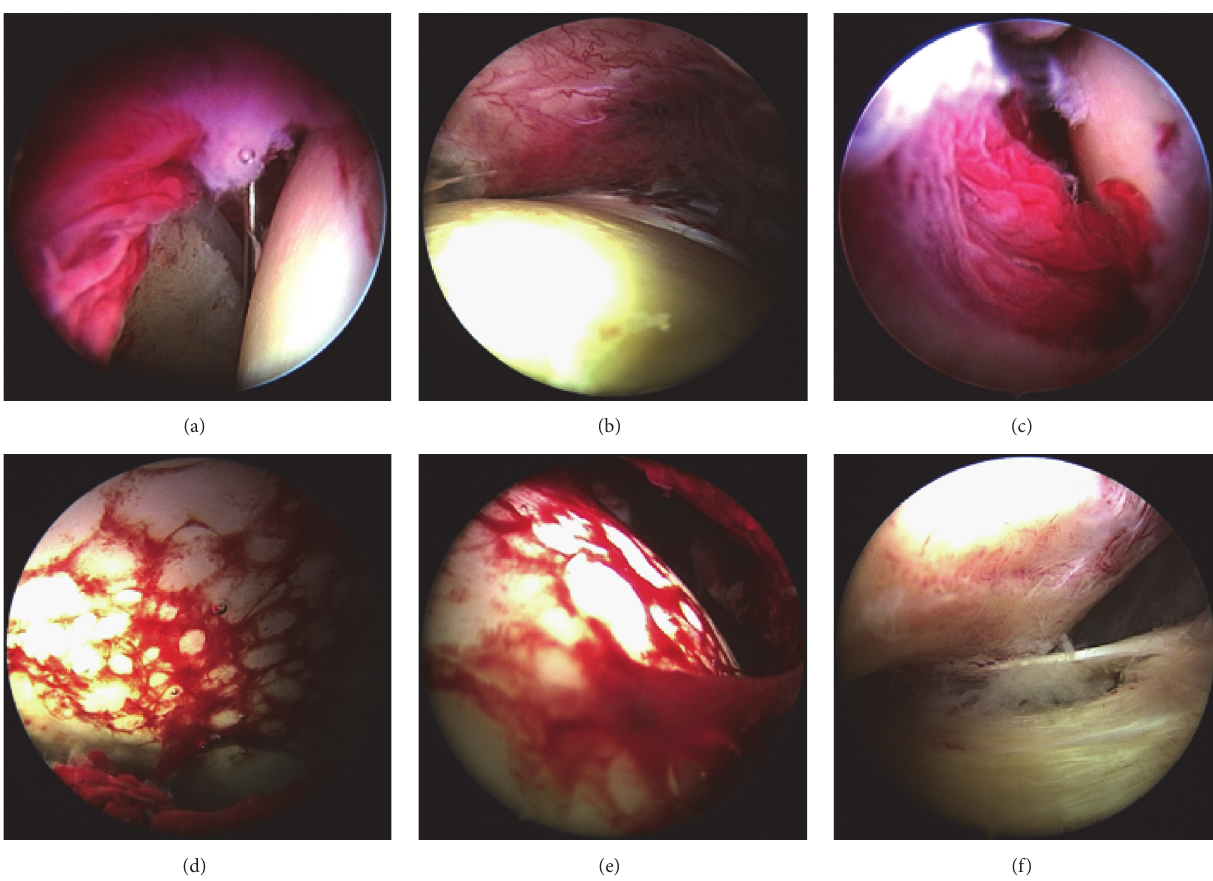
Figure 3: Arthroscopic views revealing severe synovial and capsular inflammation (a–c), fibrinous deposits on the surface of the femoral head (c and e), and pus collection in the capsular compartments